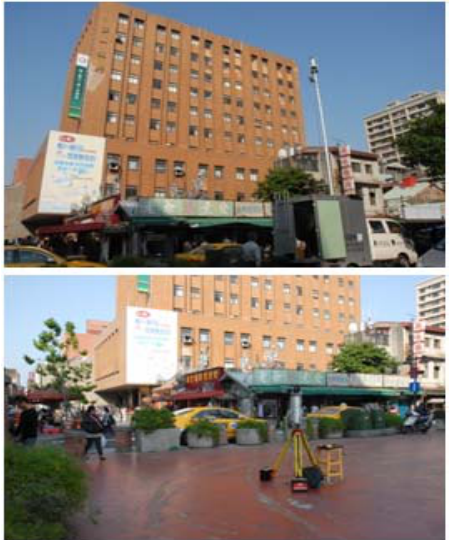
Figure 3. Scanners with mobile scanning